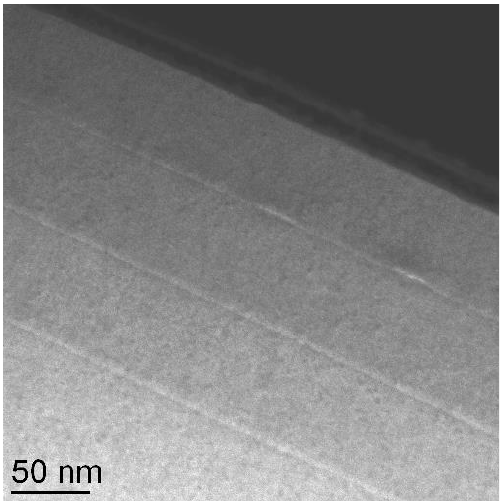
Figure 2. Annular dark-field (ADF) STEM image in cross-sectional view of three InAs thin films of nominal thicknesses of 1.6, 1.8, and 2.0 ML, i.e., near the Stranski-Krastanow transition. Quantum dots are only clearly visible in the top of the three InAs layers. Reproduced from [31].